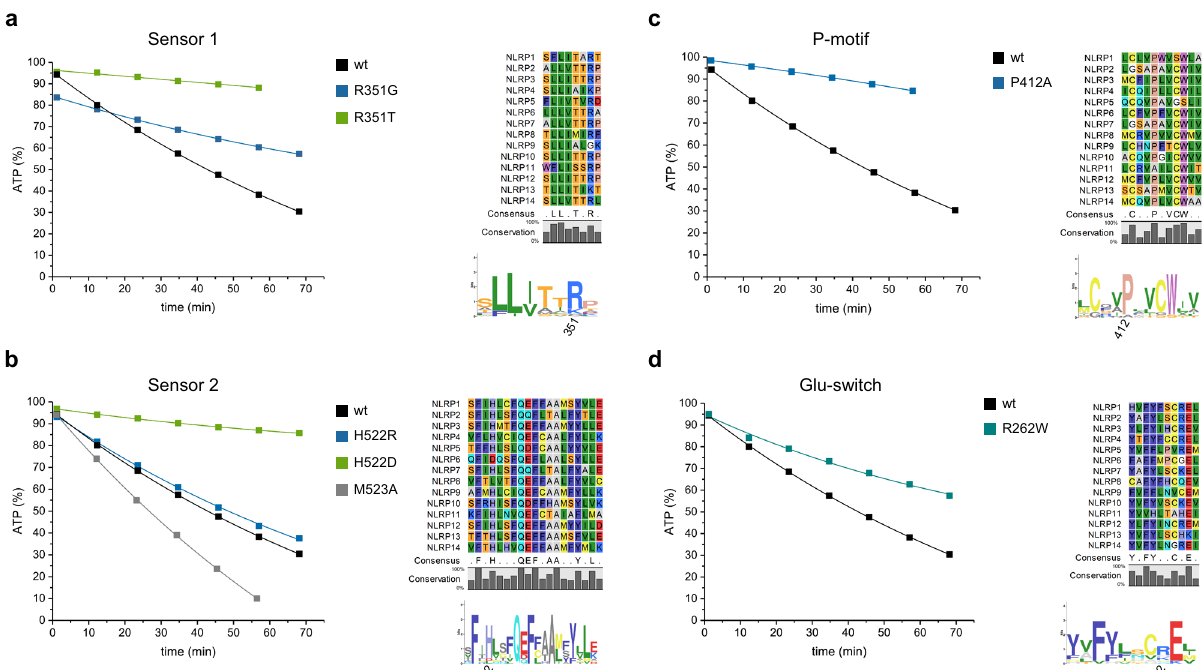
Fig. 4 Mutational analysis of sensory ATP-binding motifs in NLRP3. a MBP-NLRP3 wild type and two different Sensor 1 mutants were analyzed by RP- HPLC. The protein samples (3 µ M) were incubated at 25 °C in the presence of 100 µ M ATP and 5 mM MgCl 2 . The relative amount of ATP (%) is shown on the y-axis and the time (min) on the x-axis. The amount of ATP was determined in 10 min intervals, integrated and normalized to 100% nucleotide. Sequence alignments and sequence logos of the labeled motifs and residues are shown for human NLRP1-14. b Hydrolysis analysis of MBP-NLRP3 Sensor 2 mutants performed similarly as in a . c ATP hydrolysis analysis of the P412A mutant. d ATP hydrolysis analysis of the R262W CAPS/Glu-switch